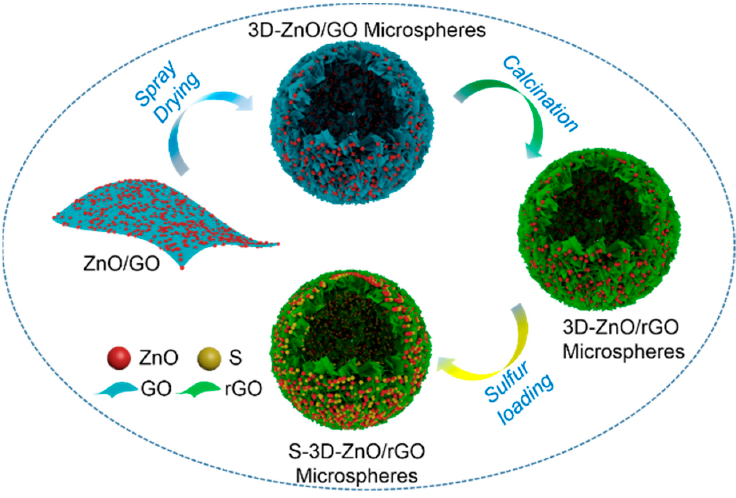
Figure 1. Schematic illustration for the synthesis of S-3D-ZnO/rGO composite.